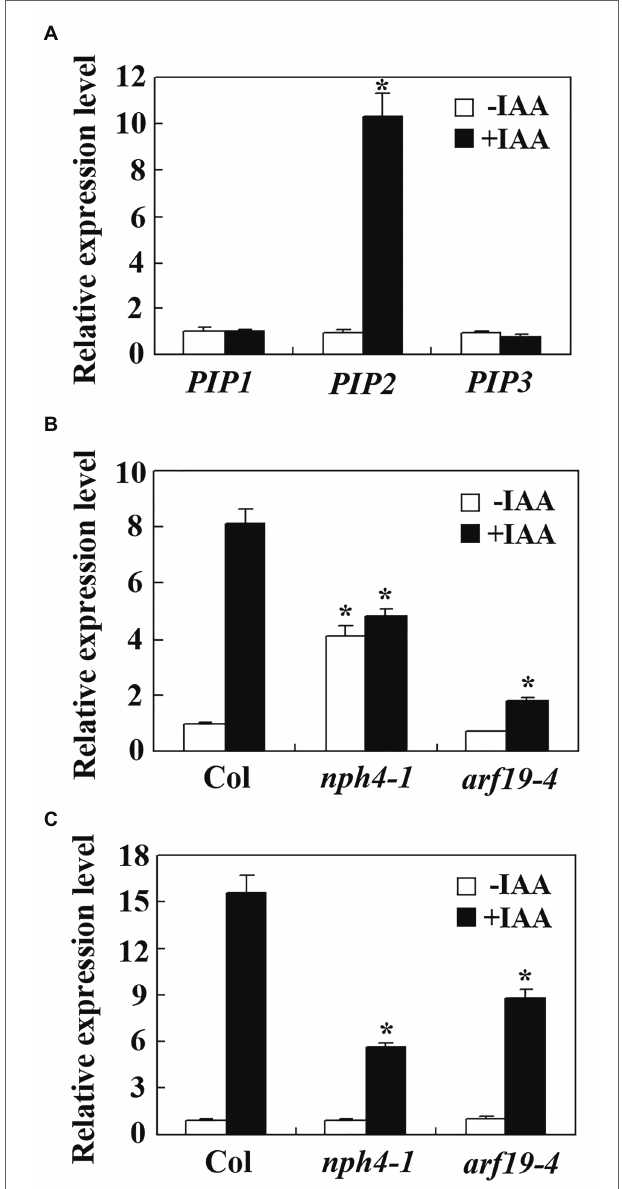
FIGURE 1 | PIP2 is an auxin response gene. (A) Expression of PAMP- INDUCED SECRETED PEPTIDES ( PIPs ) in response to auxin treatment. Ten- days-old Col wild type seedlings were treated with 10 μ M INDOLE-3-ACETIC ACID (IAA) for 4 h, total RNA was isolated and quantitative RT-PCR (qRT-PCR) was used to examine the expression of PIPs . Expression of ACTIN2 ( ACT2 ) was used as an inner control, and the expression level of corresponding PIP genes in the control seedlings was set as 1. Data represent mean ± SD of three repeats. *significantly different from absent of IAA (student’s t test, p < 0.001). Expression of PIP2 (B) and IAA19 (C) in the nph4-1 and arf19-4 mutants in response to auxin treatment. Ten-day-old Col wild type, nph4-1 and arf19-4 mutant seedlings were treated with 10 μ M IAA for 4 h. Total RNA was isolated and qRT-PCR was used to examine the expression of PIP2 or IAA19 . Expression of ACT2 was used as an inner control, and the expression level of PIP2 or IAA19 in control seedlings of the Col wild type was set as 1. Data represent mean ± SD of three repeats. *significantly different from the corresponding expression level in the Col wild type seedlings (student’s t -test, p < 0.001). The experiments were repeated three times with similar results.